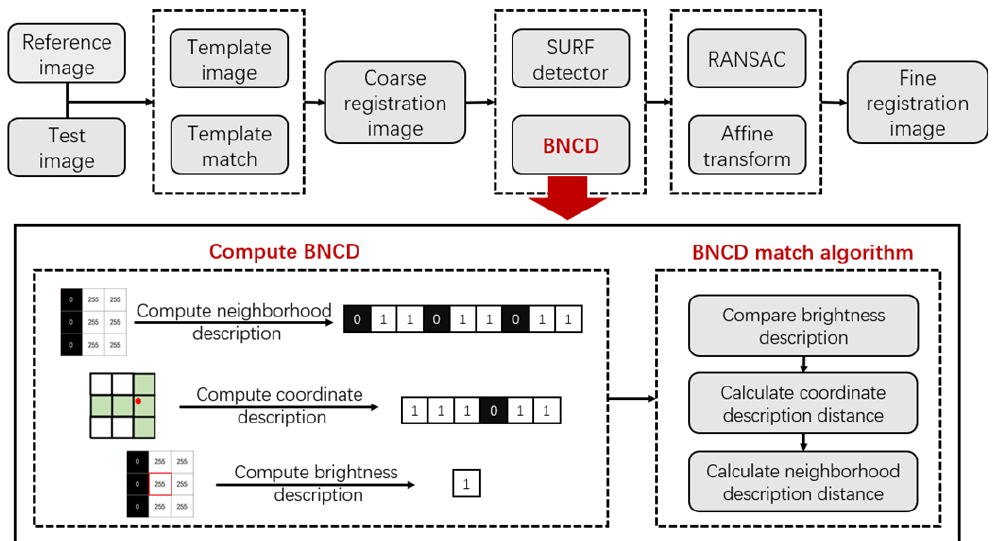
Figure 1. The proposed registration algorithm.